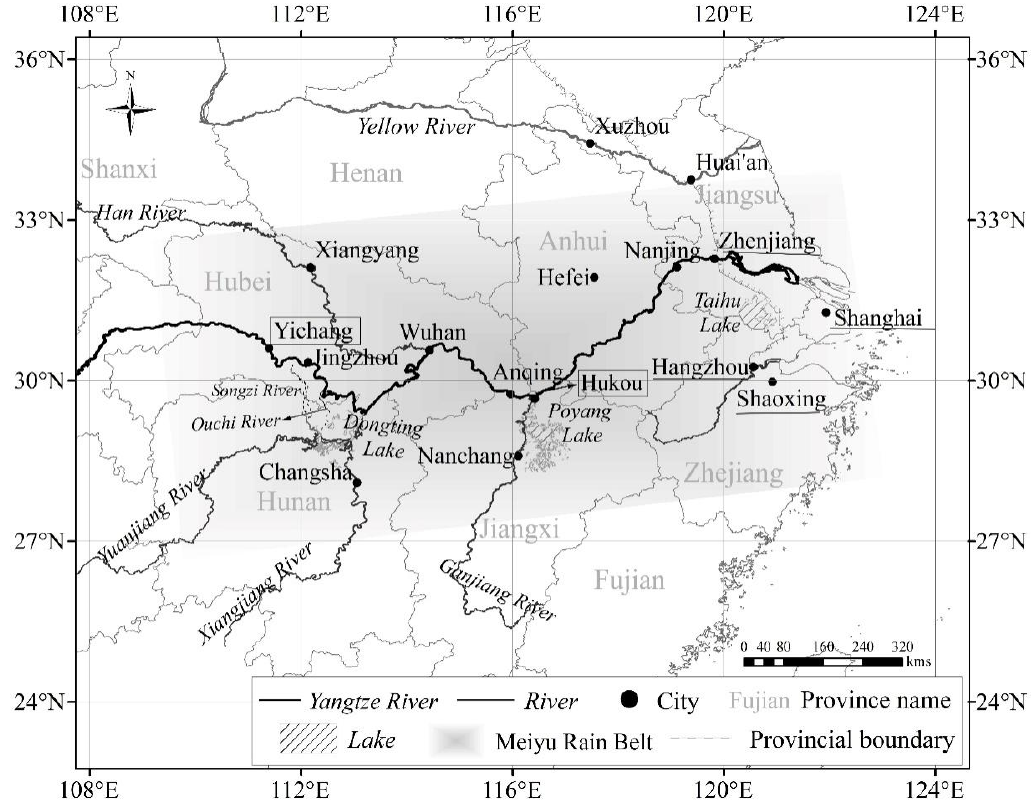
Figure 1. Map of the study area. Figure note: The Yellow River in 1820 is shown. Underlined cities, e.g., “Hangzhou”, are the cities recorded in the diary. The cities with frame, e.g., “ ”, are the demarcation points of each section of the Yangtze River.